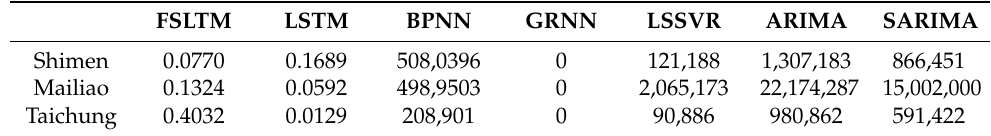
Table 4. Comparison of the training error (RMSE) with various prediction models for different wind power plants.